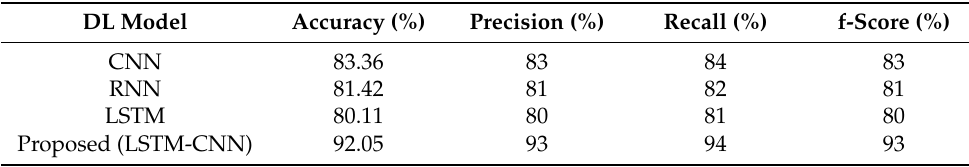
Table 12. The proposed model (LSTM+CNN) versus various DL